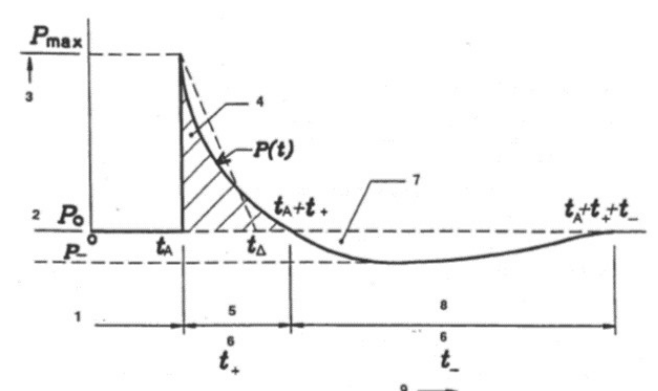
Fig. 1 : Friedlander blast wave profile (Krehl and Peter